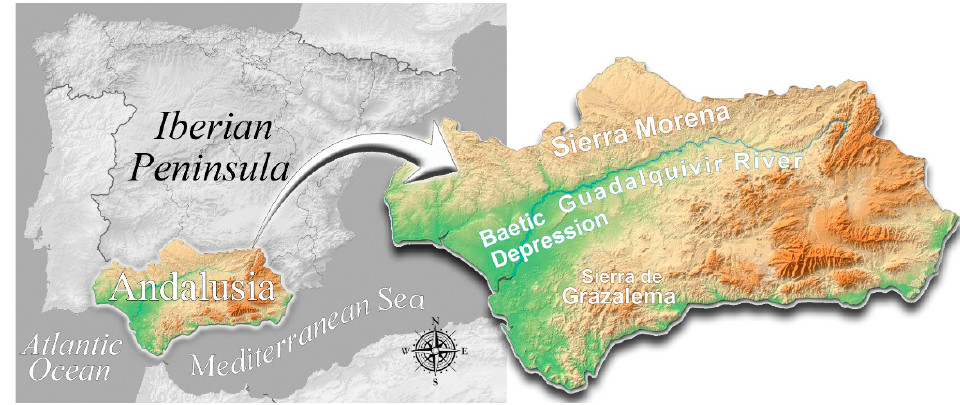
Figure 1. Location of Andalusia at the south of the Iberian Peninsula. At the right, some of the orographic features mentioned in the text.